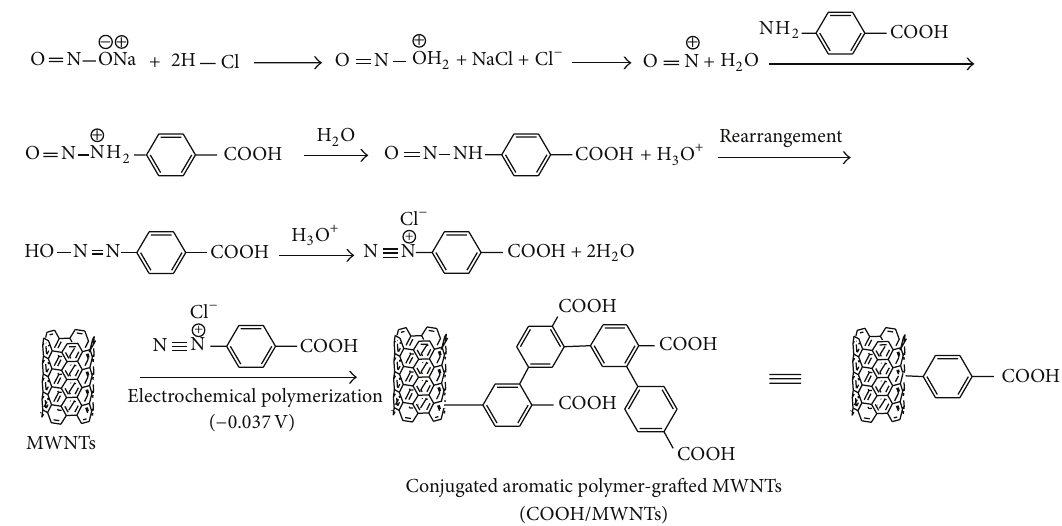
black suspension was dropped onto the working electrode of the SPE. Synthesized 4-carboxyphenyl diazonium salts